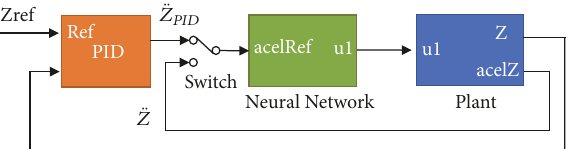
Figure 3: Adaptive altitude neurocontrol